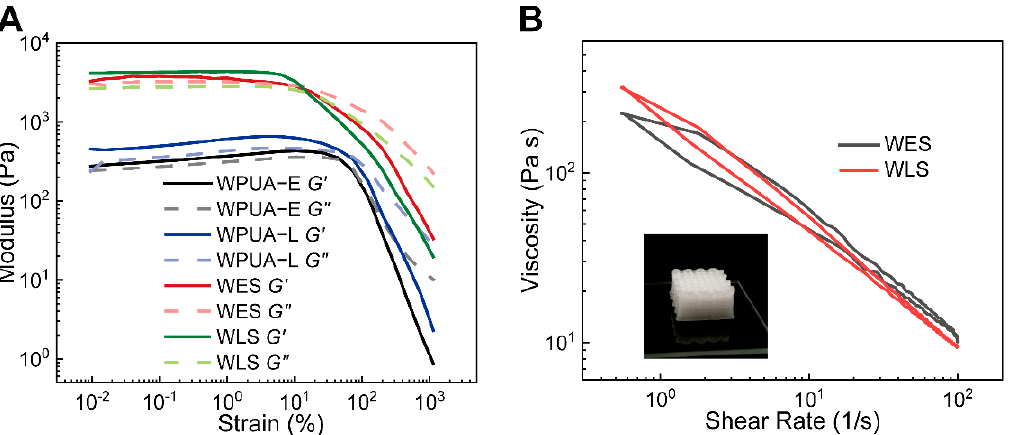
Figure 5. ( A ) Oscillatory amplitude sweeps (strain, 0.01 to 1000%; angular frequency, 1 rad/s) of emulsions. ( B ) Hysteresis curves of WES and WLS at shear rate 0.5–100 1/s.